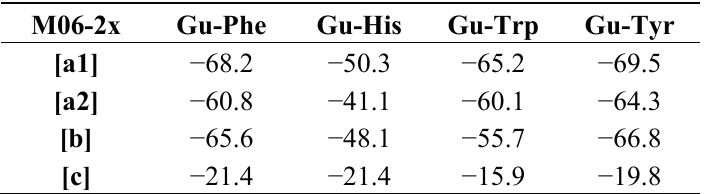
Table 1. Interaction energies (E i , kJ·mol − 1 ) for all the complexes studied at